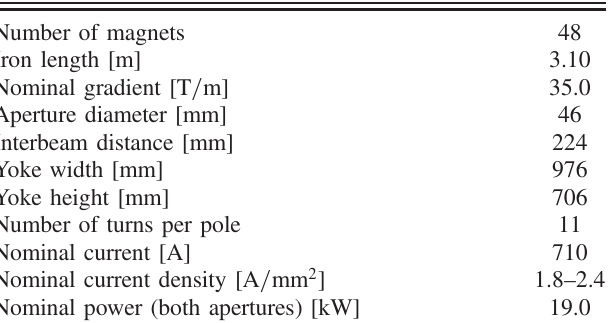
TABLE VII. Main parameters of the MQW quadrupoles in the LHC.